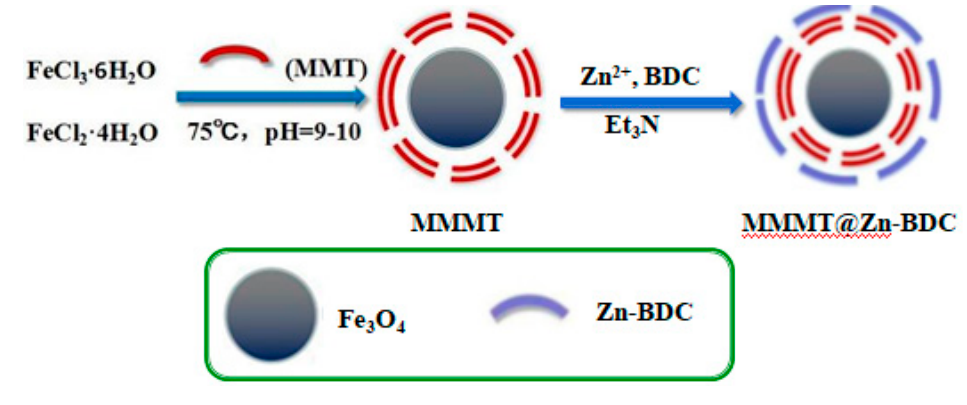
Figure 1. Synthesis of MMMT@ Zn-BDC.